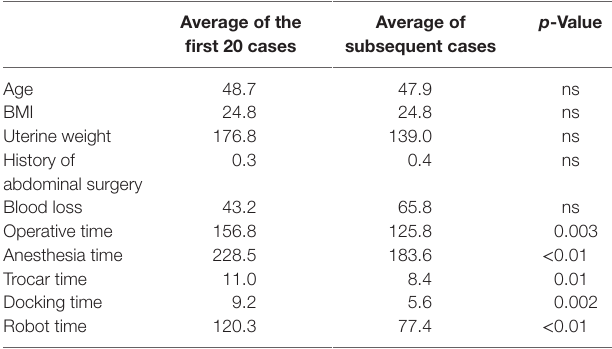
TaBle 3 | comparison between the average data for the first 20 cases and the following ones.